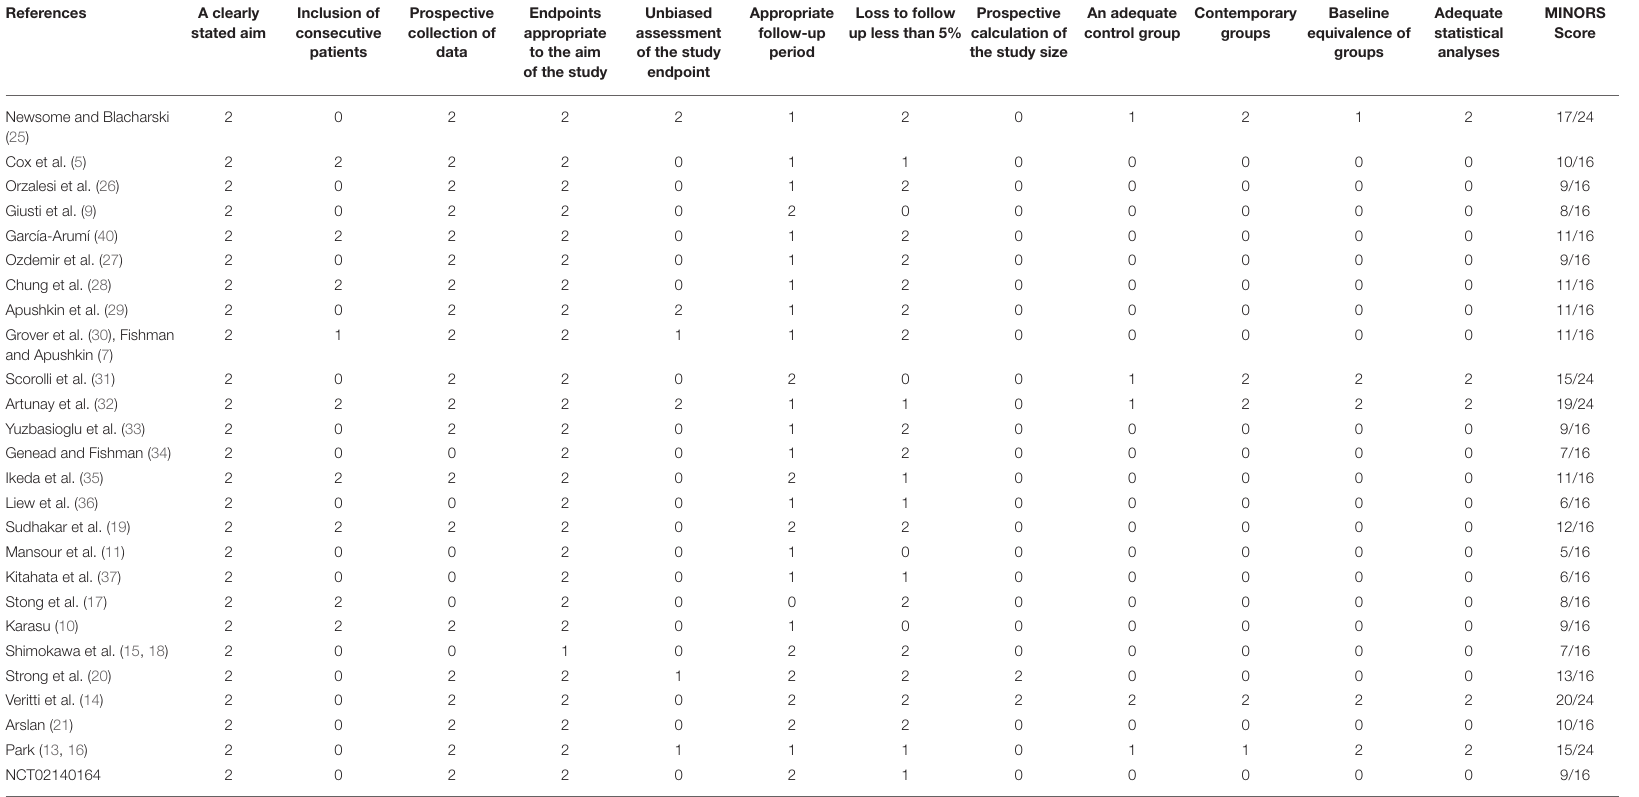
TABLE 2 | Quality assessment of non-RCT studies using the MINORS